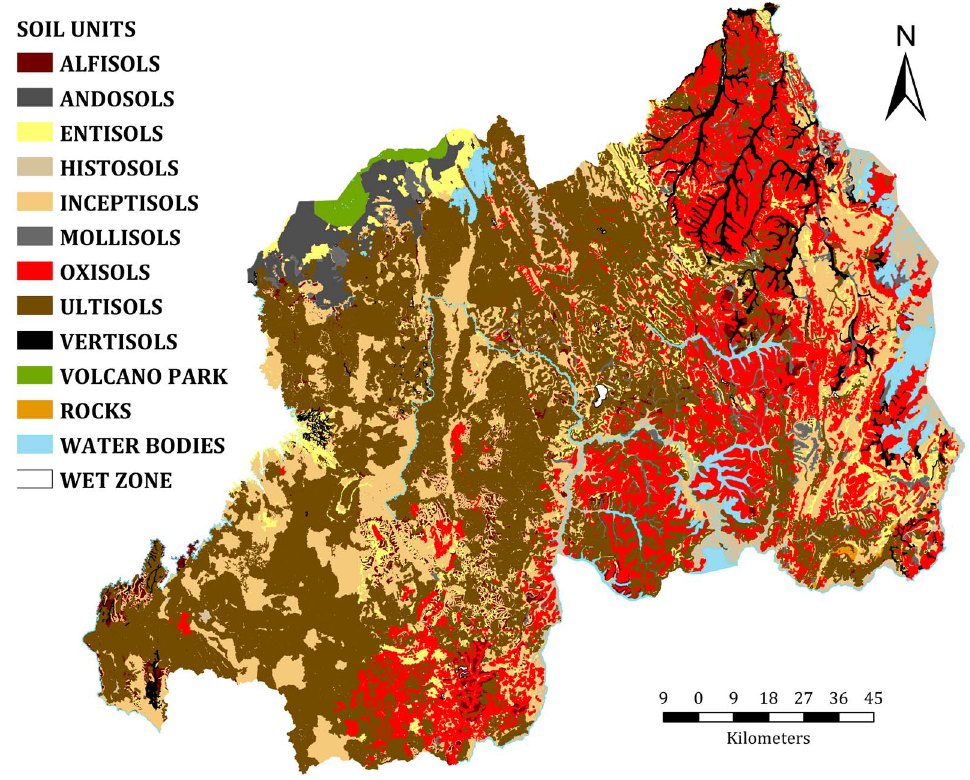
Figure 5. Soil map of Rwanda. Soils are classified using the USDA Soil taxonomy (Source: Data collected from the Ministry of Agriculture and Animal Resources, using the Rwanda soil database) after [32].